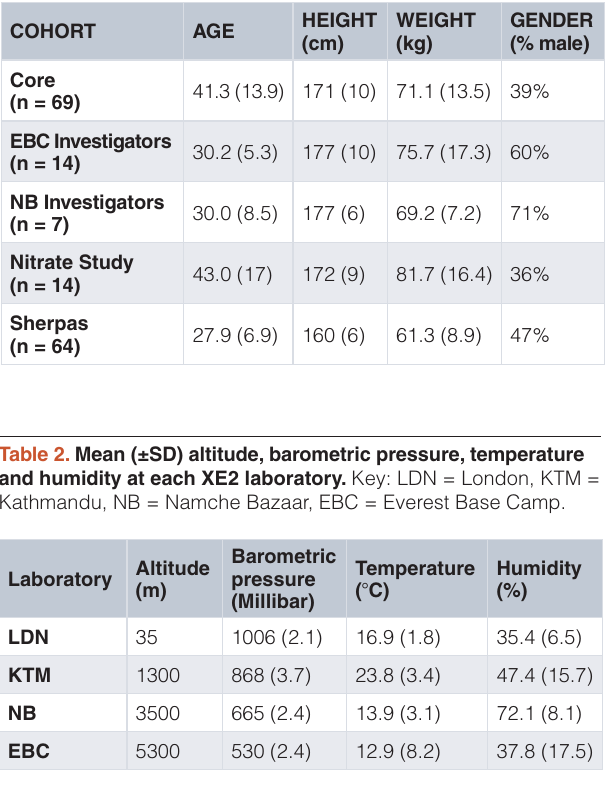
Table 1. The mean (±SD) baseline characteristics for each cohort (excluding the children cohort). Key: NB = Namche Bazaar, EBC = Everest Base Camp.